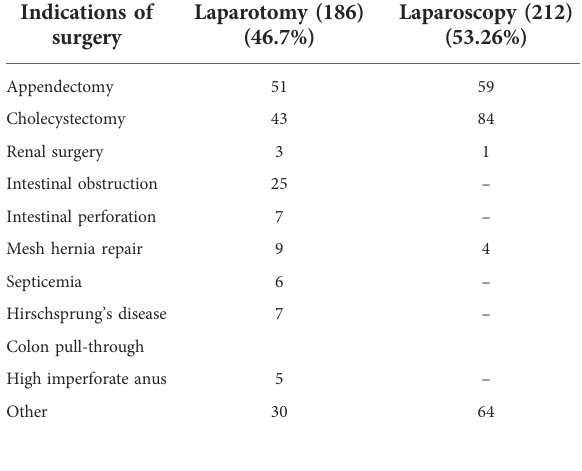
TABLE 5B Patient ’ s pro fi le depending on the type and indication of previous general surgery. Previous abdominal general surgery ( n = 398)